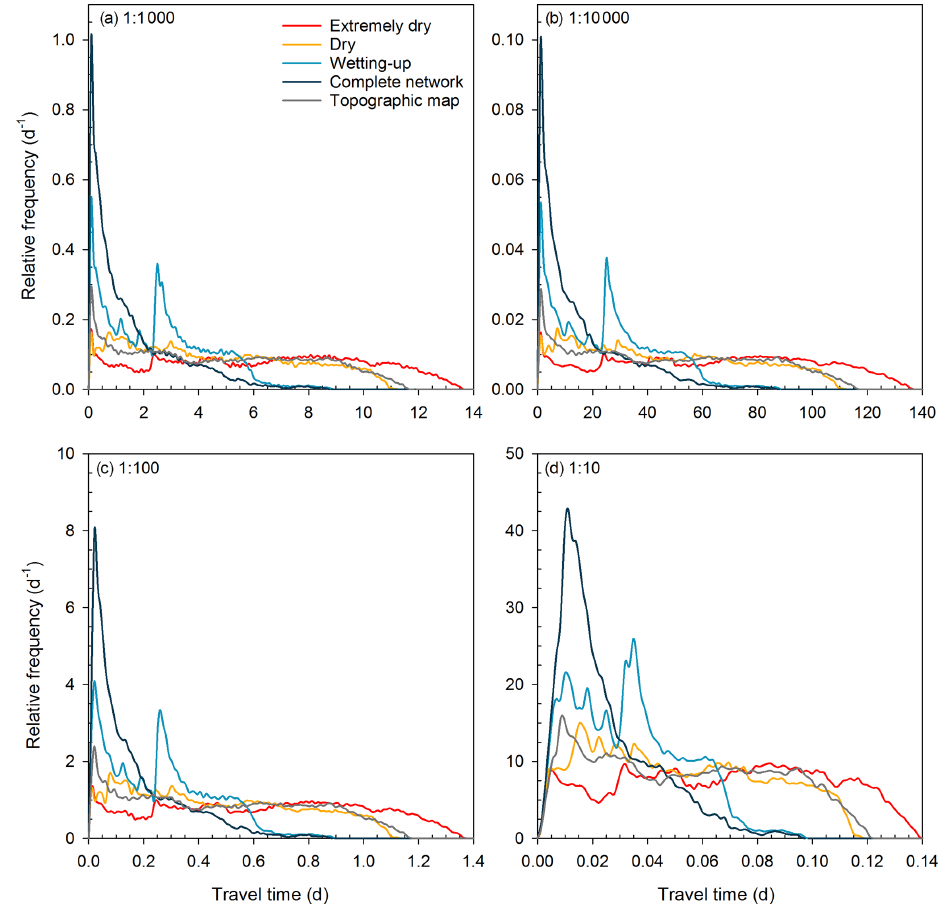
Figure 6. Different assumed subsurface flow velocities change the travel times but not the shapes of their distributions. The panels show the travel time distributions for the five flowing stream networks, assuming a surface velocity ( v s ) of 0.5ms − 1 and subsurface velocities ( v h ) of (a) 5 × 10 − 4 ms − 1 (as used in Fig. 4), (b) 5 × 10 − 5 ms − 1 , (c) 5 × 10 − 3 ms − 1 , and (d) 5 × 10 − 2 ms − 1 . The value shown in the upper left corner of each panel represents the ratio of the subsurface to surface velocities ( v h : v s